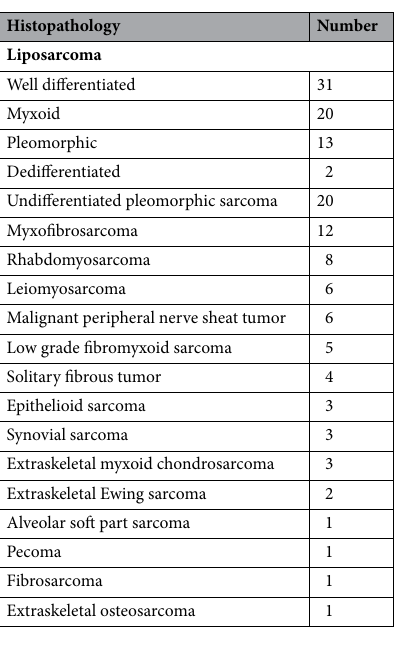
Table 2. Histopathological features of the tumors.